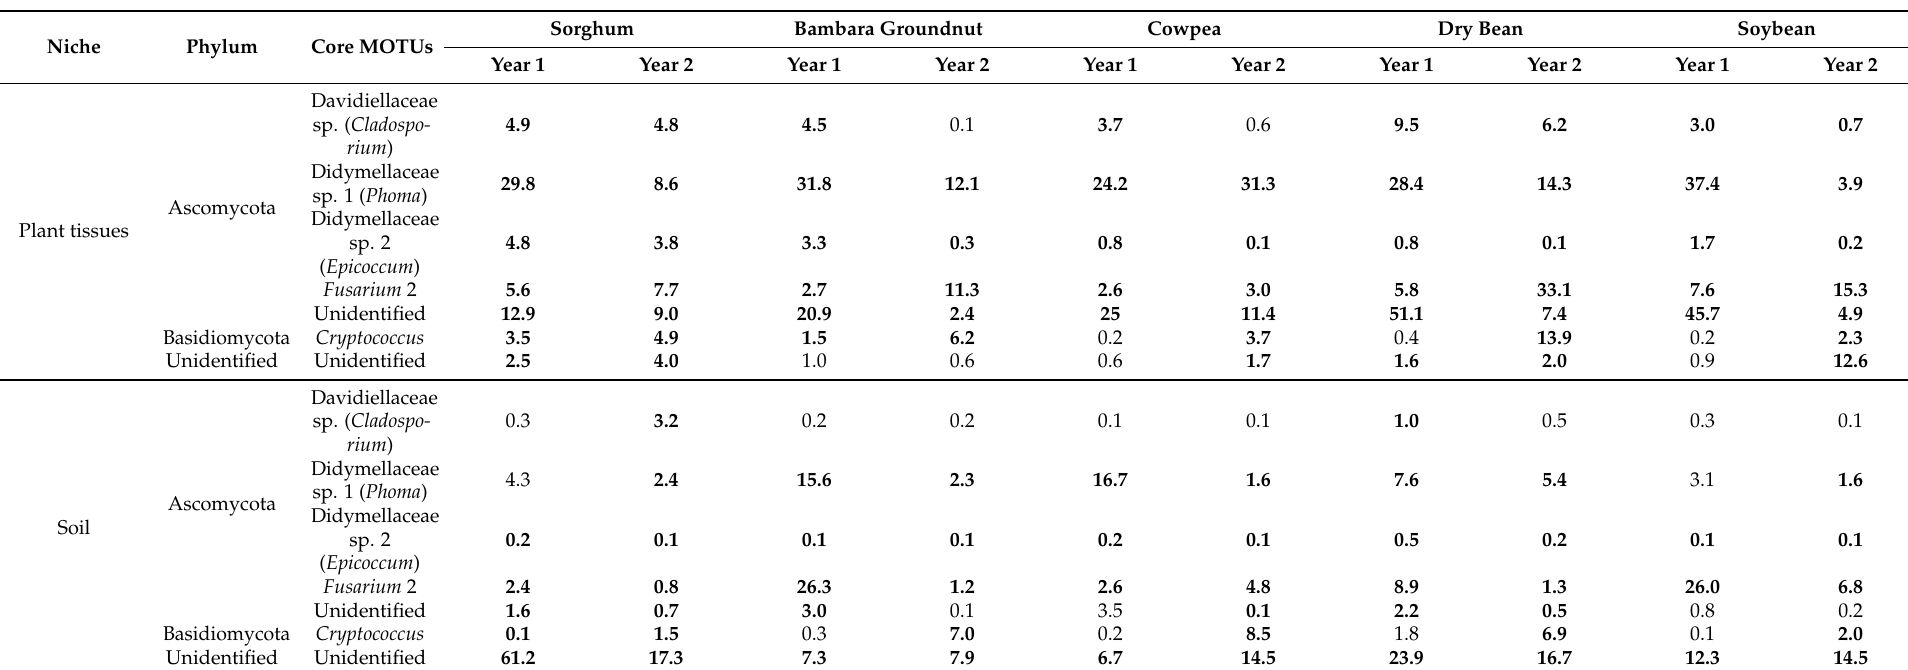
Table 2. Summary of the relative abundance (%) of core molecular Operational taxonomic units (MOTUs) that were assigned in plant tissue and soil, year one and year two in the sorghum-legume intercrop. The bold numbers illustrate abundance greater than 1%.